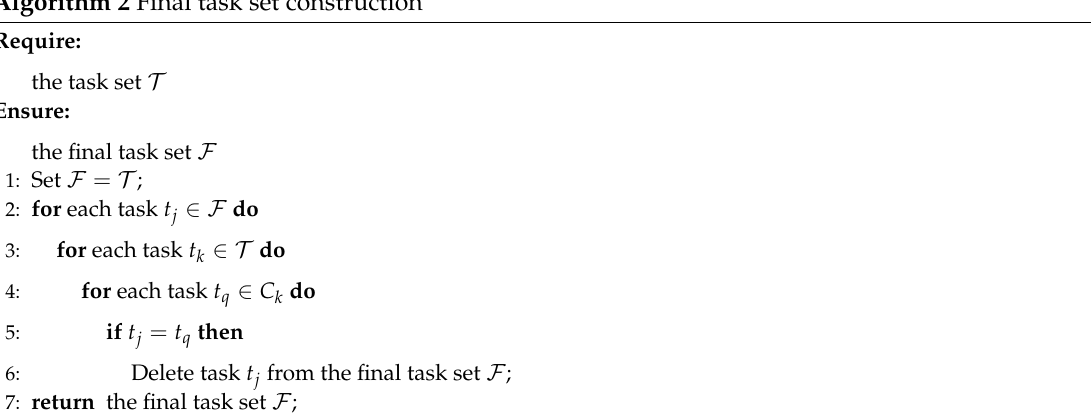
Algorithm 2 Final task set